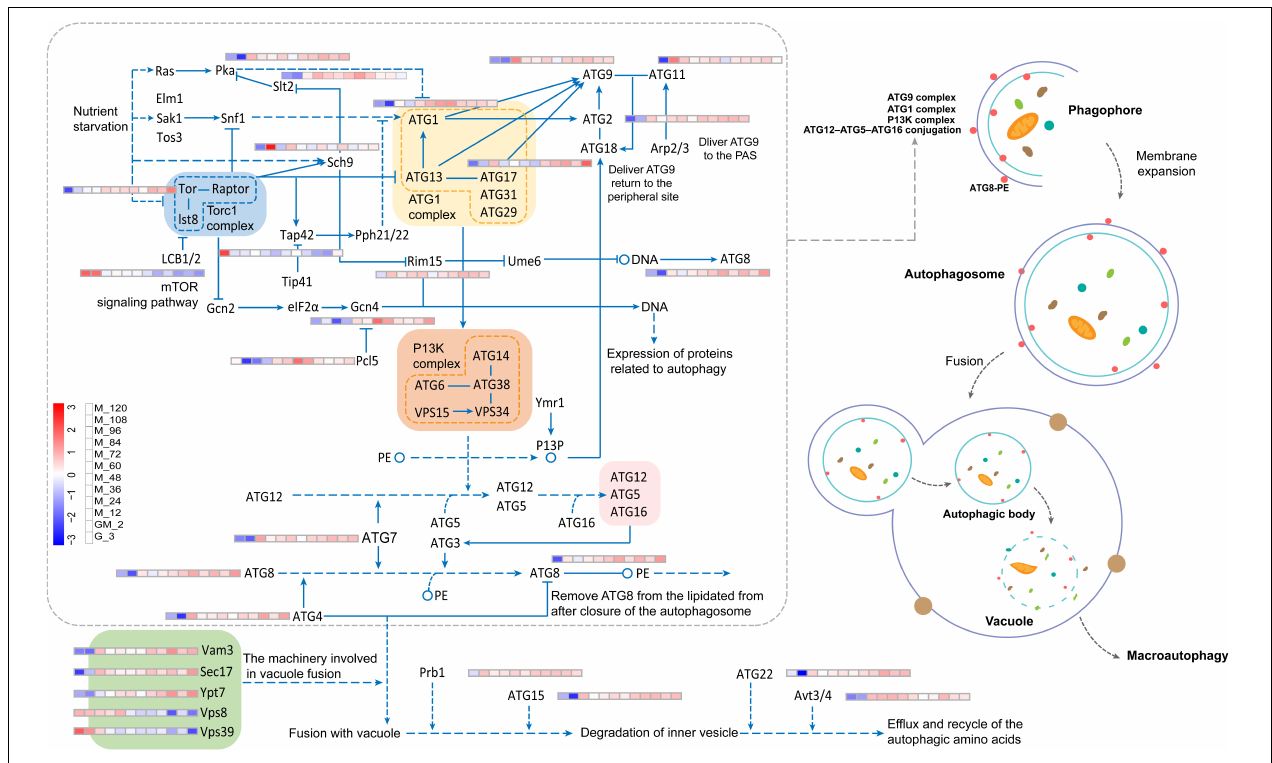
FIGURE 7 | Changes in proteins involved in the autophagy